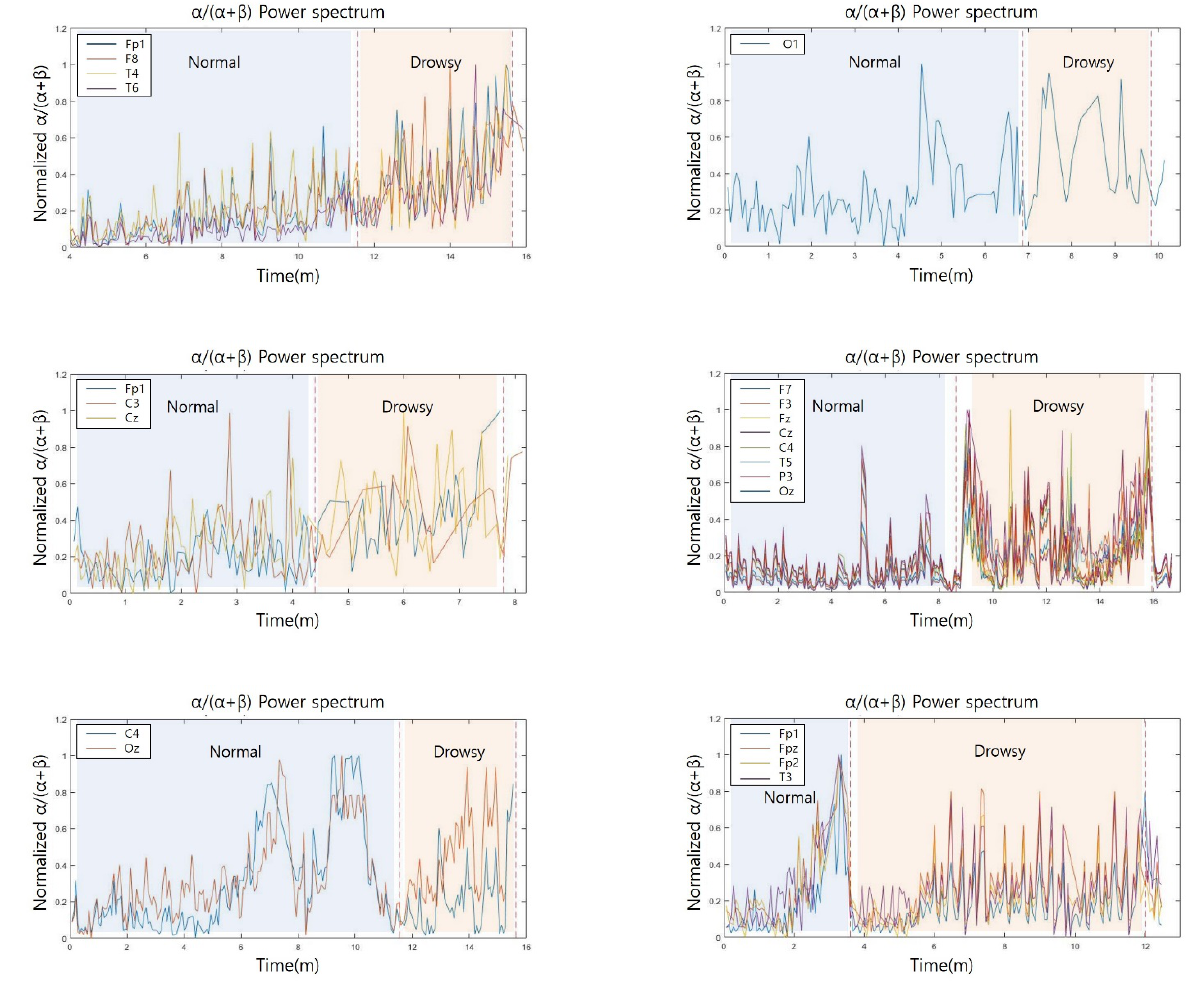
Figure 5. α /( α + β ) power spectrum of 6 Figure 5. α/(α + β) power spectrum of 6 participants.